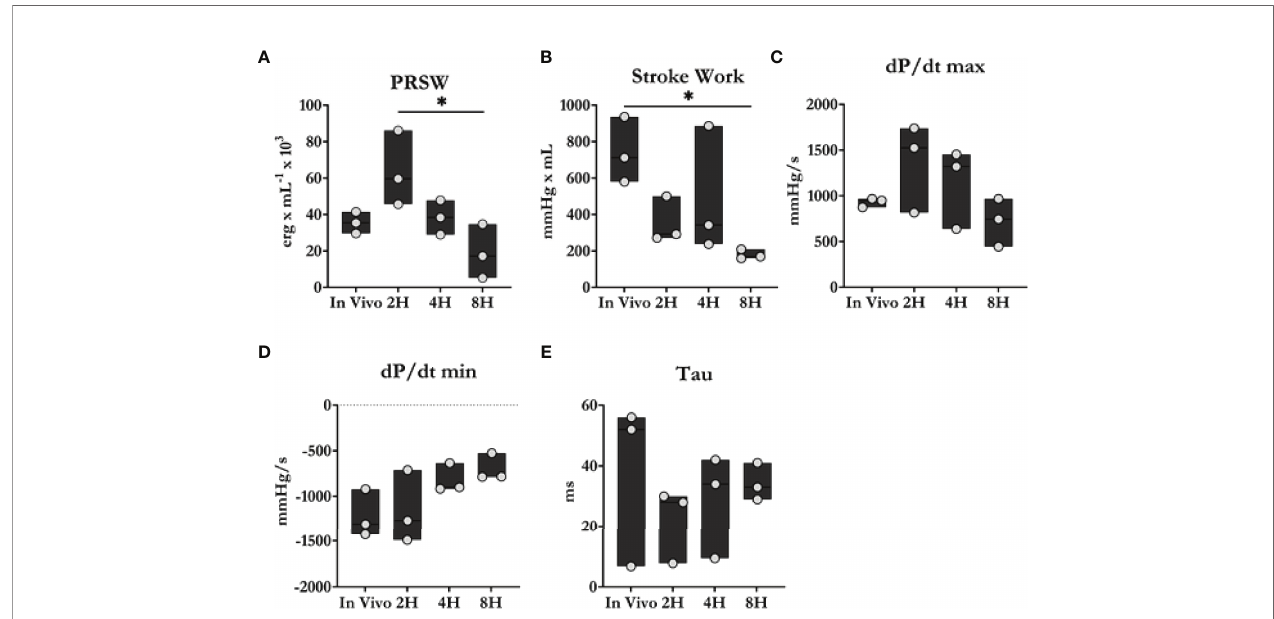
FIGURE 3 | Cardiac contractility comparison between in vivo and ex situ conditions. (A) Preload recruitable stroke work (PRSW). (B) Stroke work. (C, D) Maximum and minimum dP/dt. (E) Time constant of relaxation. Overall, heart function progressively declined during the 8 h perfusion period. Data were reported as median values and compared using the Kruskal-Wallis test. Post-hoc analyses were performed using Dunn ’ s multiple comparisons test. * P <